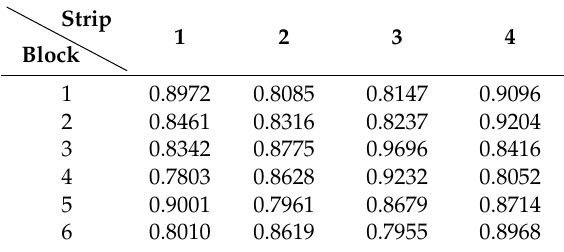
Figure 15. Correlation between the SCV and the number of compaction times in Strip 1. Table 3. Specific determined coefficient ( R 2 ) between the SCV and the number of compaction times for NGM.